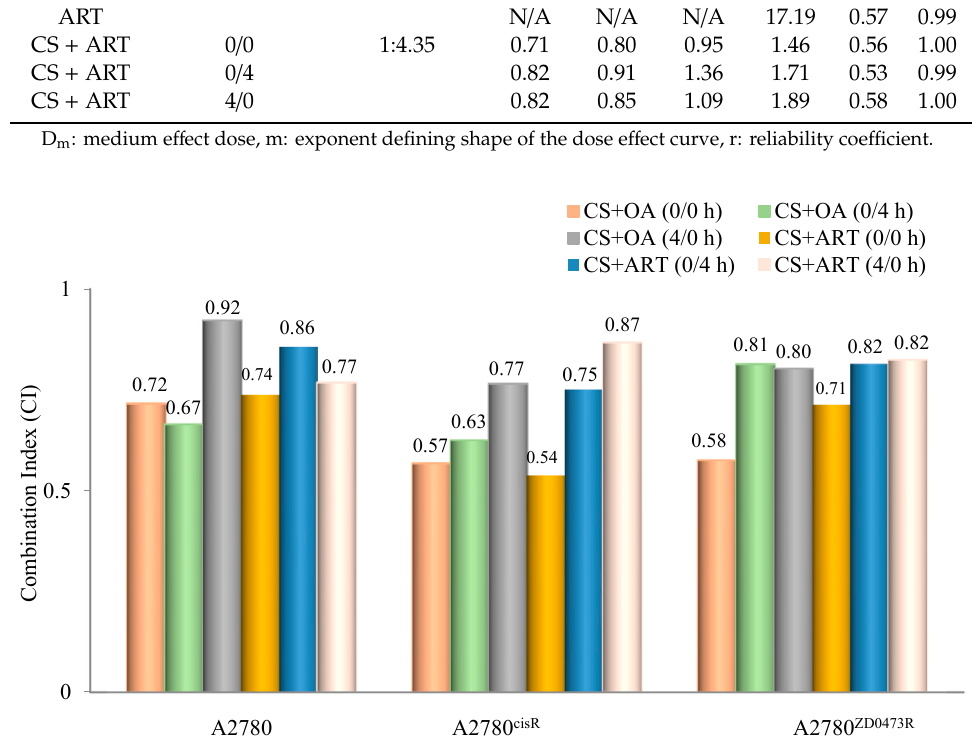
Figure 2. Graphical representation of combination indices (CI) applying to binary combinations of CS with OA and ART at ED50 (where drugs were added in equipotent ratios based on IC 50